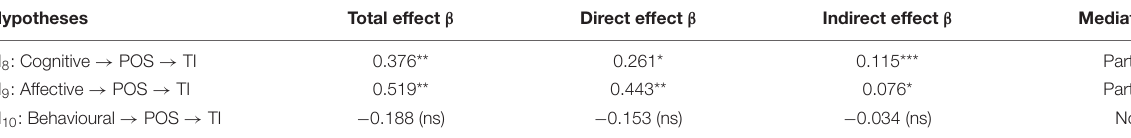
TABLE 4 | Mediation analysis.